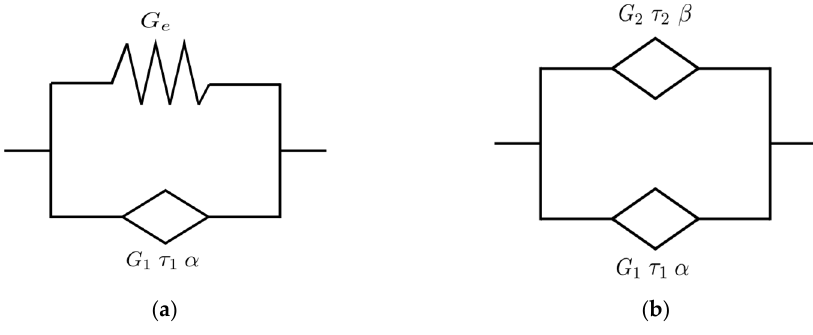
Figure 4. Kelvin fractional model with ( a ) one spring-pot; ( b ) two spring-pots.